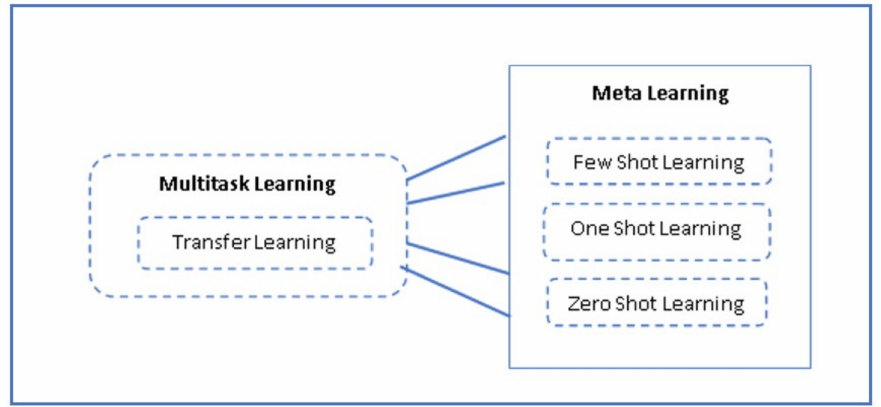
Figure 6. Relationship Between Machine Learning and Meta Learning. Table 3. Datasets and Performance Metrics Used in Literature Proposing Deep Learning Methods for Malware